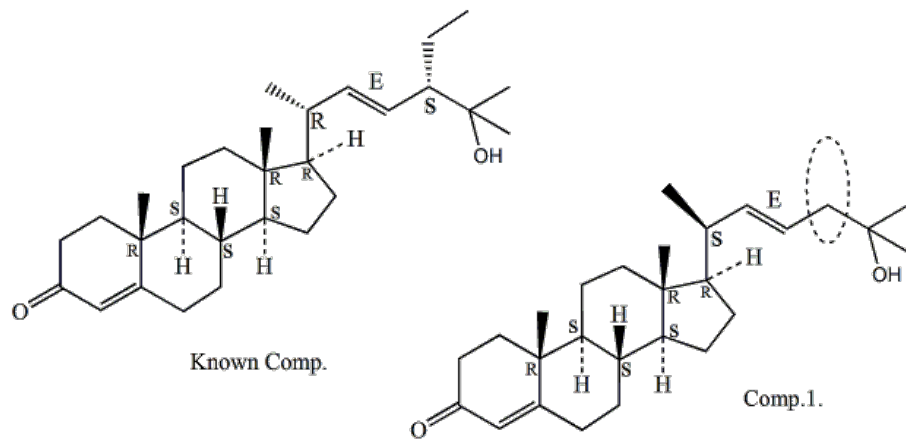
Figure 2. The key HMBC and NOESY correlations of compound 1 .